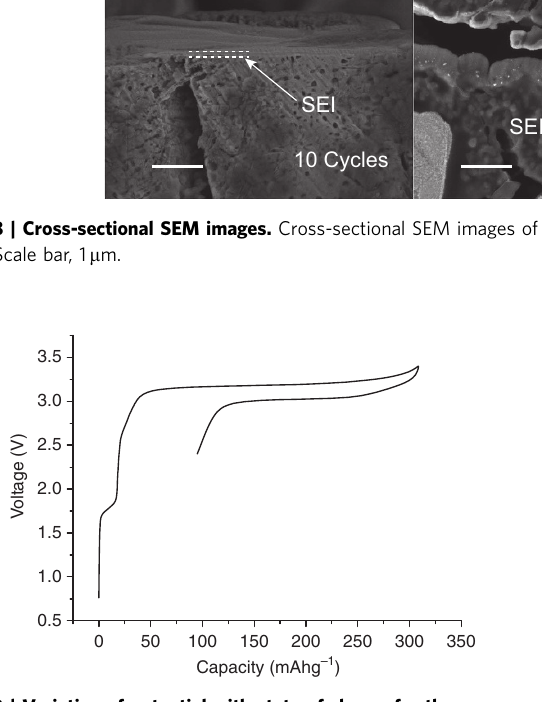
Figure 9 | Variation of potential with state of charge for the Li(V 0.5 Ti 0.5 )S 2 /LiCoO 2 cell. Rate 100mAg (cid:2) 1 of anode, cells were cycled between 3.4V and